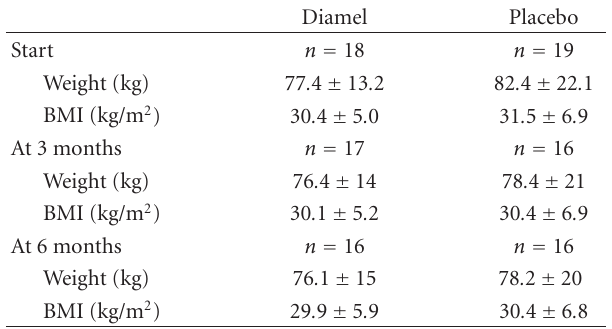
Table 4: Evolution of weight and BMI in women with PCOS. Diamel Placebo